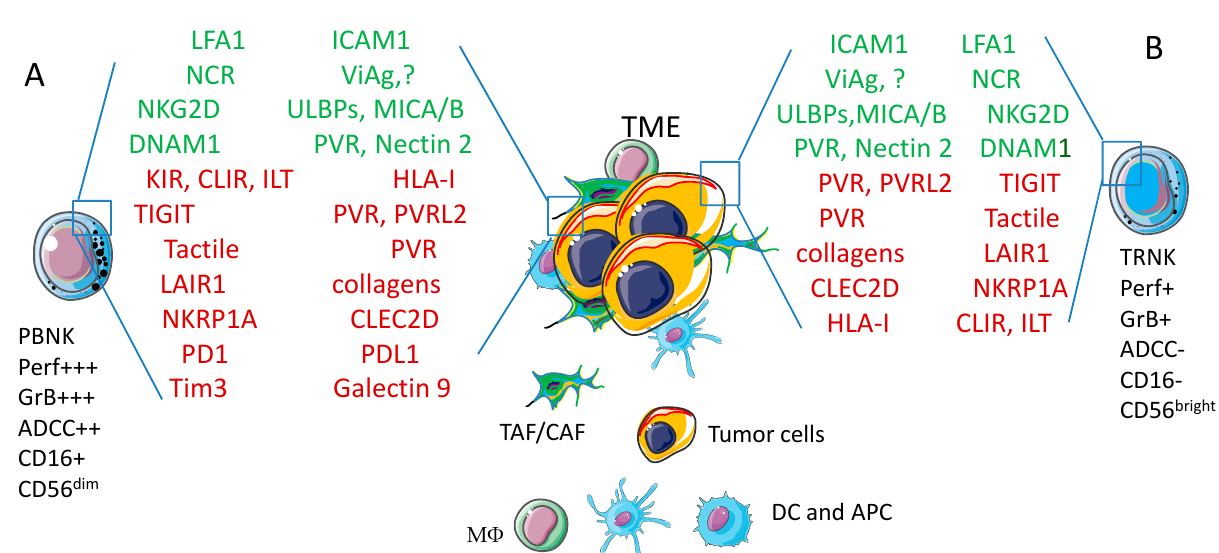
Figure 2. Phenotype of peripheral blood (PBNK) and tissue resident (TRNK) NK cells. The large majority of PBNK ( A ) express CD16 and through this receptor for the Fc portion of immunoglobulins can activate the ADCC that induces the release of perforin and granzymes to kill target cells. A minority of PBNK does not express CD16, but displays high surface amounts of CD56 (CD56 bright ) antigen; these PBNK cells are similar to tissue TRNK ( B ). NK cells express a plethora of activating (green) or inhibiting (red) receptors that can interact with the corresponding ligands expressed on tumor cells within the tumor microenvironment (TME). Other cells of the TME, such as tumor/cancer associated fibroblasts (TAF/CAF), dendritic cells (DC) or antigen presenting cells (APC) and macrophages (M Φ ) are also depicted. The engagement of activating receptors triggers cytolysis of tumor cells and/or the release of cytokines while the interaction of inhibiting receptors with corresponding ligands impair NK cell-mediated activities. The final net effect (triggering or inhibition) is determined by the balance of these positive and negative signals. The receptors and ligands mentioned in the figure are analyzed in detail in the text. Acronyms. LFA1: lymphocyte function antigen 1; ICAM1: intercellular cell adhesion molecule 1; NCR: Natural Cytotoxicity Receptor; ViAg: viral antigen; ?: not yet identified ligands; NKG2D: NK